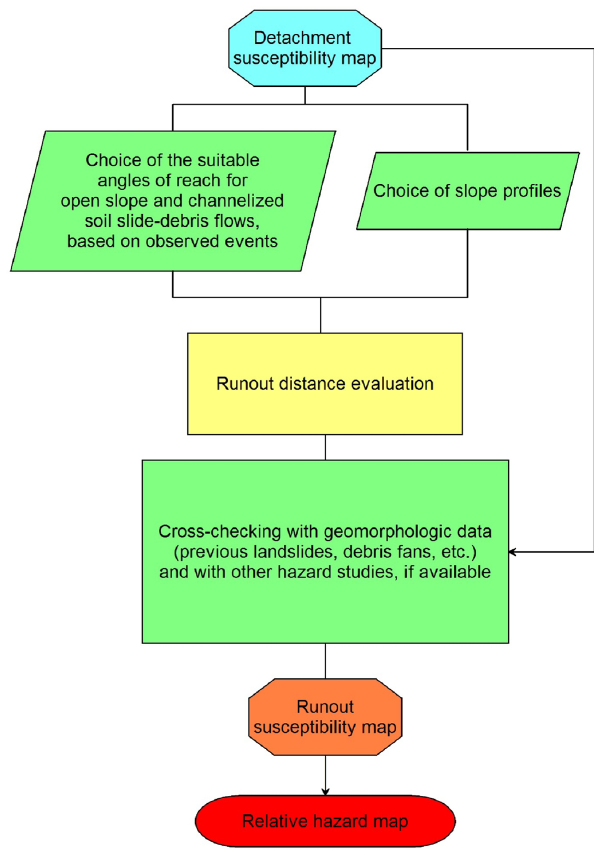
Fig. 14. General procedure adopted to create the Landslide Rel- ative Hazard map of the BANCR (after Calcaterra et al., 2003a –